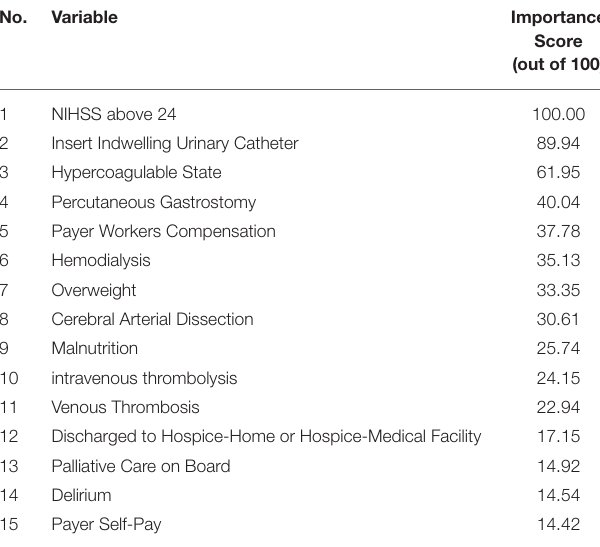
TABLE 3 | Variable importance scores of the XGBoost model with ROSE-sampling (Design 2).